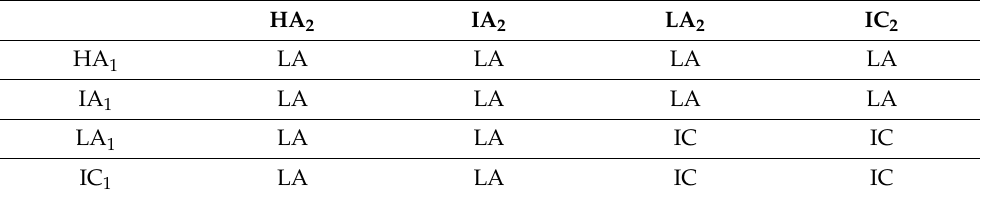
Table A2. The fuzzy rule table when u 3 is LA 3 .